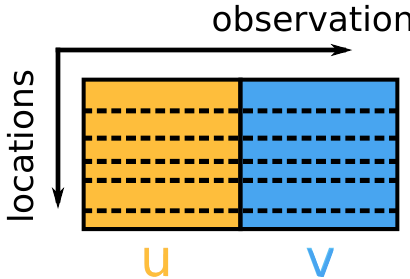
Figure 2. Matrix of input data. The dashed lines indicate the rows of the matrix containing the data collected at the optimal sensor